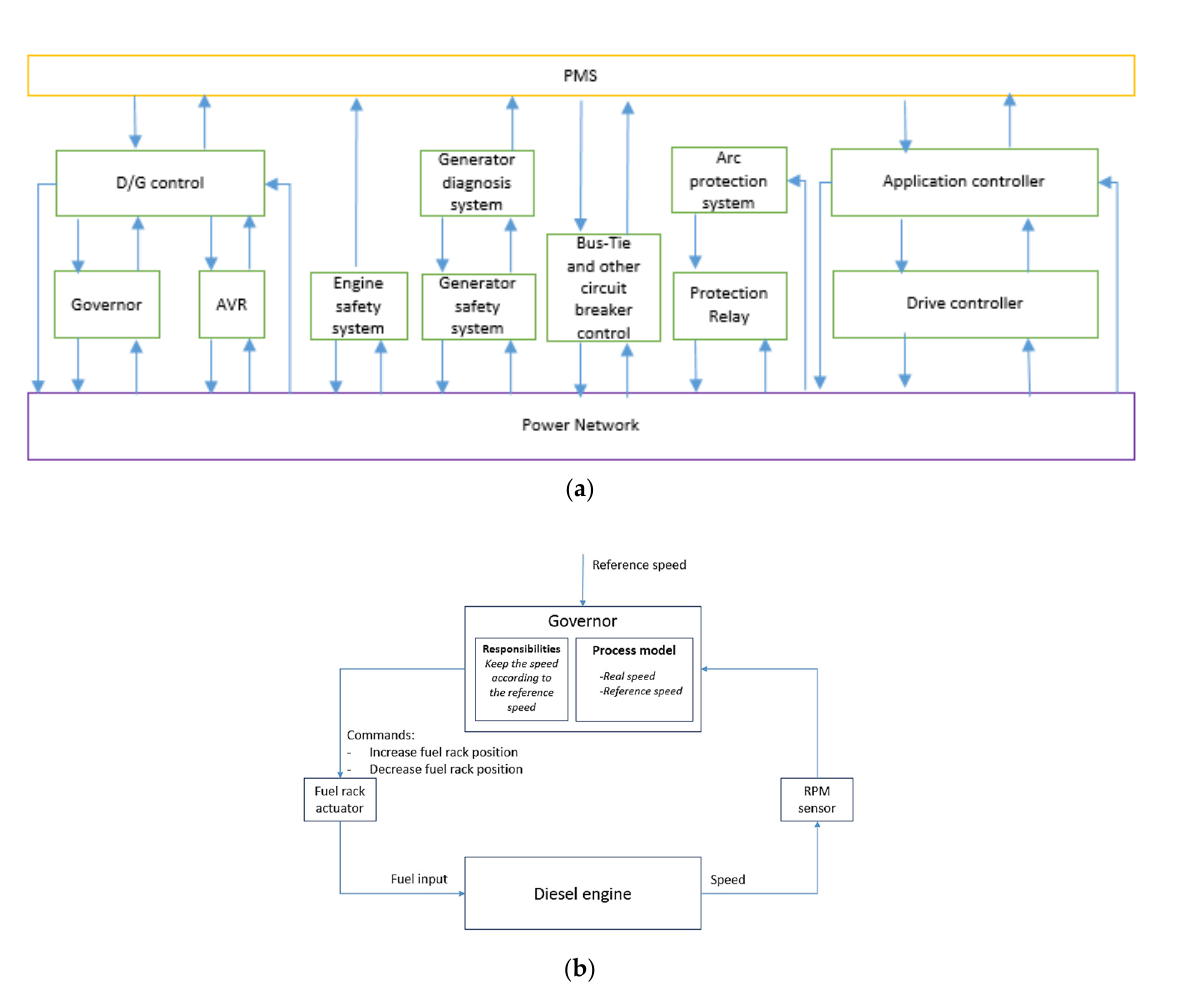
Figure 4. Developed DEP system control structure; ( a ) Analysed system overall control structure; ( b ) Refined engine governor control structure. Table 5. The identified list of sub hazards, safety constraints and existing safety measures for the investigated system.